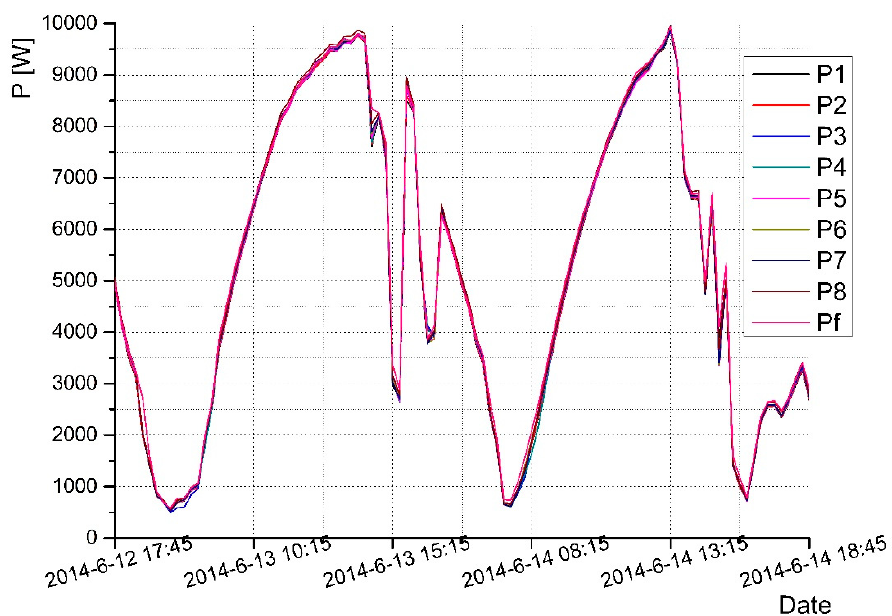
Figure 3. Comparison between the measured power at all inverters of PVSE and simulated values during two consecutive summer days.